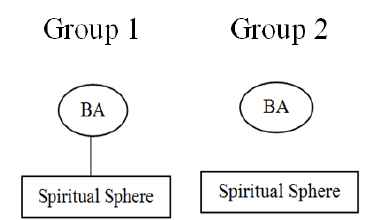
Figure 1. Correlation relationships of the indicator “BA” Note: correlation at a significance level of